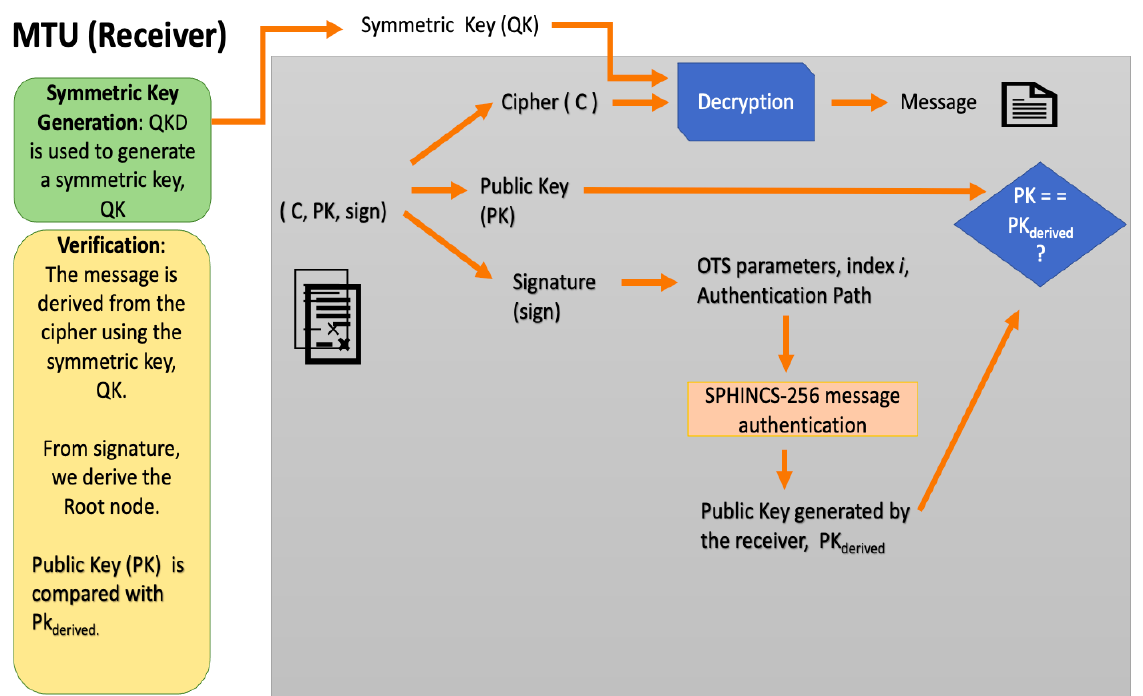
Figure 3. The structure of our proposed scheme. It includes decryption and signature